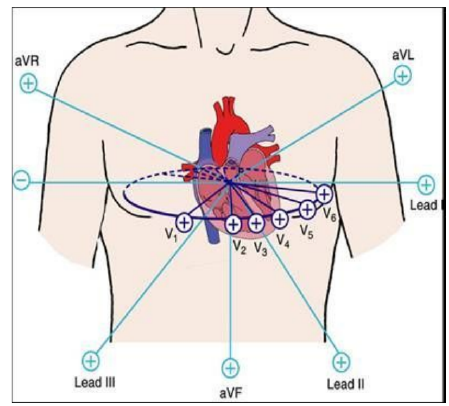
Figure 1. Electrocardiogram (ECG) conventional leads orientation. The importance and significance of electrocardiography is well recognized not only in the diagnosis of MI, but also in detecting conduction disturbances or abnormalities and various types of arrhythmia. The advent of modern medical therapy of unstable angina and acute MI, and the development of interventional cardiology, has increased the significance of electrocardiography in contemporary cardiology. The ECG waves and fiducial points are named in alphabetical order. These are called the P, QRS-complex, and T-waves, as shown in Figure 2. The R-peak is generally known as the focal point of an ECG beat, and the time interval between two consecutive R-peaks is called the R-R interval (also referred to as the RR interval). The amplitude, shape, and time interval of these waves provide significant information about the state of the heart. The QRS- complex reflects the ventricular depolarization generated by the positive wave when impulse spreads towards the positive pole of the respective ECG lead [9,10]. MI usually affects the ventricles, and therefore the QRS abnormalities are associated with the ST-T abnormalities. The ST-segment elevation is mostly the earliest change in acute MI and its early detection is of much significance from the medical treatment point of view. Premature ventricular complexes (PVC), also known as ventricular ectopic (V), are the premature beats originating from slow ventricular activation and reflected as a wide QRS complex in ECG. These may reflect underlying cardiac diseases, such as the ischemic heart disease. According to the Association for the Advancement of Medical Instrumentation (AAMI), the non-life threatening arrhythmia types can be categorized into five classes: non-ectopic or Normal (N), supraventricular ectopic (S), ventricular ectopic (V), fusion (F), and other unknown (Q) categories [11]. The process of detecting different types of arrhythmia into its appropriate cardiac condition is called